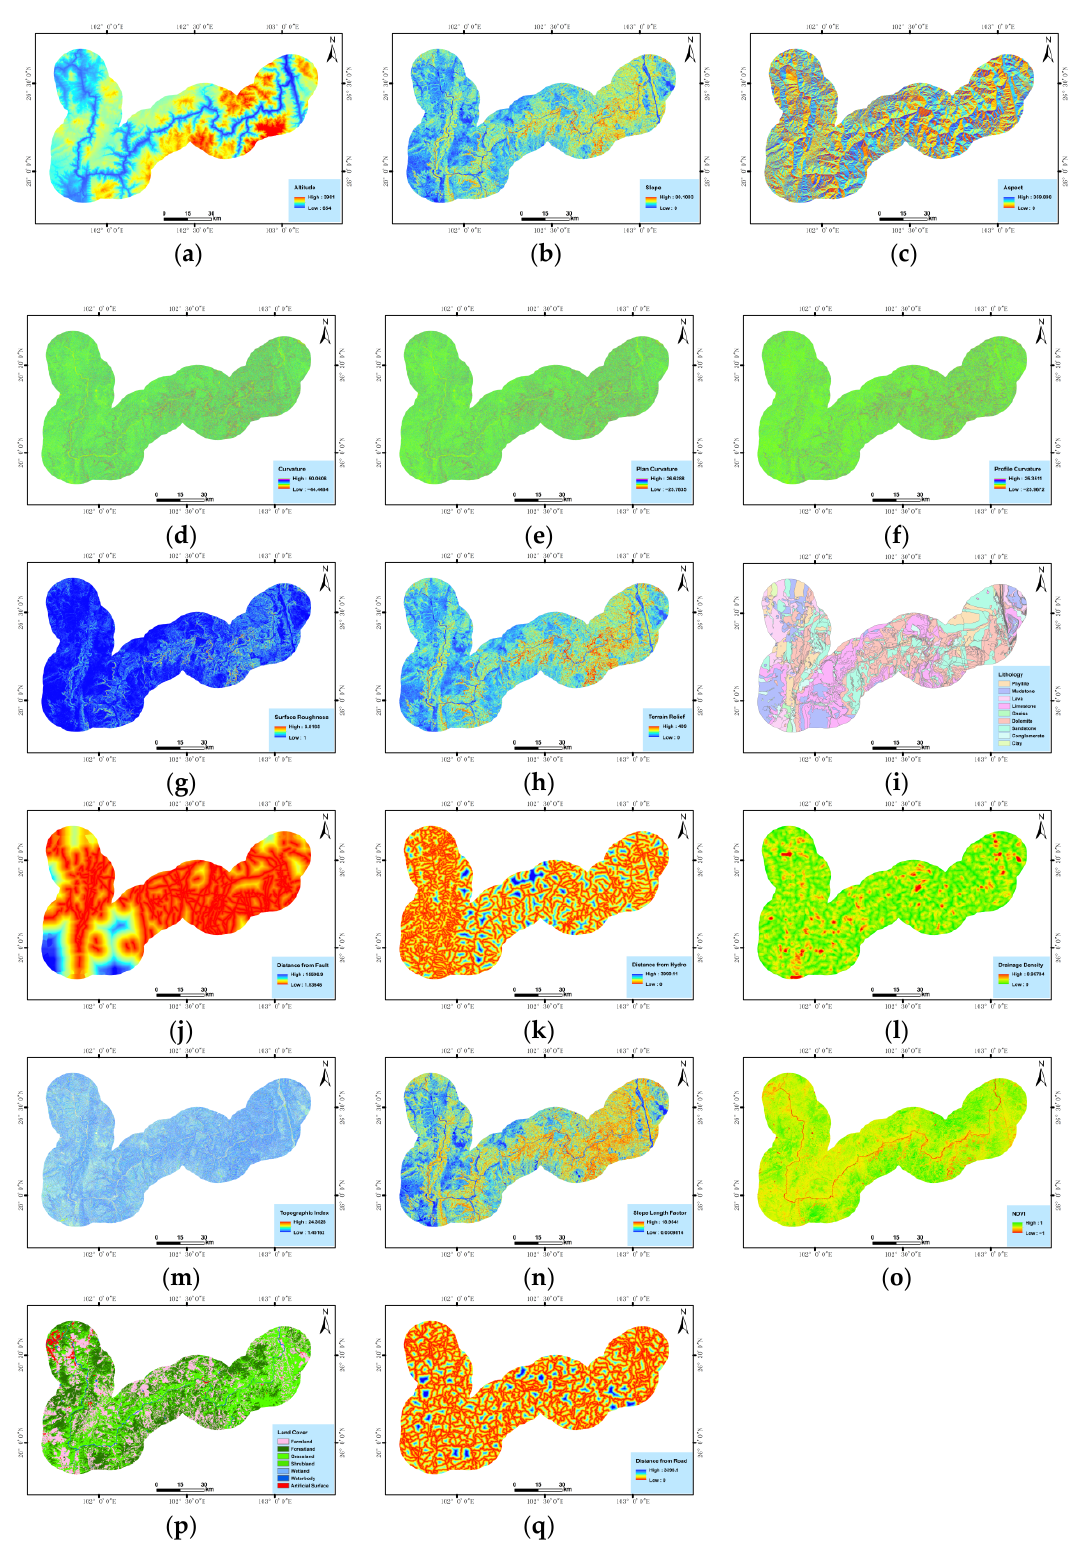
Figure 7. Result of influence factors. ( a ) DEM; ( b ) Slope; ( c ) Aspect; ( d ) Curvature; ( e ) Plane Curvature; ( f ) Profile Curvature; ( g ) Surface Roughness; ( h ) Terrain Relief; ( i ) Lithology; ( j ) Distance from Fault; ( k ) Distance from Hydro; ( l ) Drainage Density; ( m ) Topographic Index; ( n ) Slope Length Factor; ( o ) NDVI; ( p ) Land Cover; ( q ) Distance from Road. Table 2. List of potential active landslide influence factors.